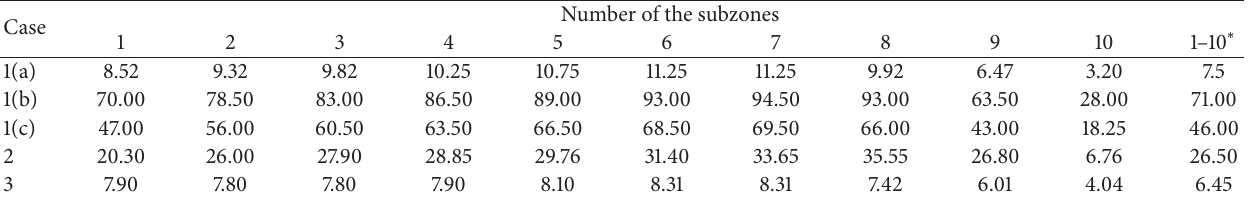
Table 3: Enrichment percentages of UO 2 TRISO particles (Case 1(a)) and embedding percentages of 15% enriched UO 2 , 22.5% enriched UO 2